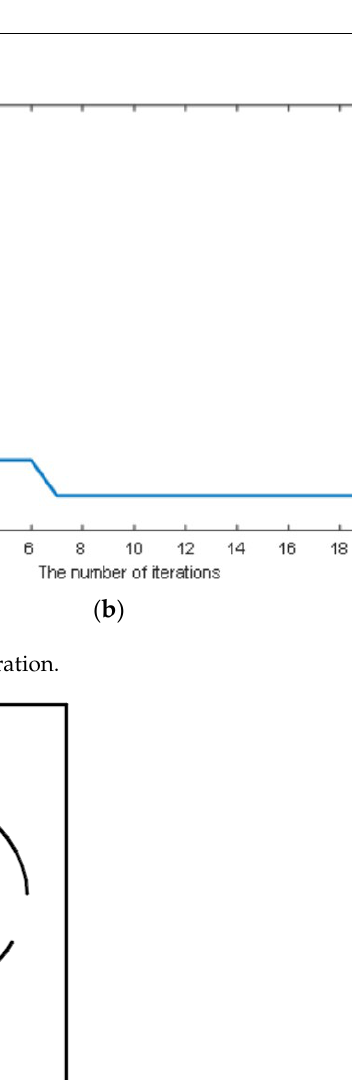
( b ) Figure 4. Two stages of PRM algorithm: ( a ) offline learning stage; ( b ) online planning stage. 4.2. Improved GA Huang et al. [35] proposed an IGA to solve problems such as a slow convergence speed, falling into the local optimum easily, an unsmooth planning path and the high cost of the traditional genetic algorithm. The hybrid non-multi-string selection operator was